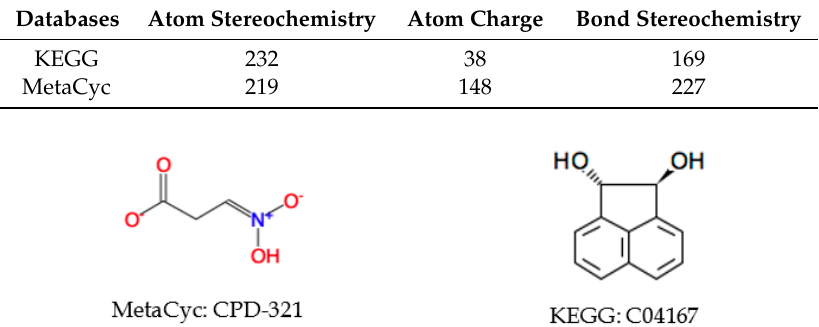
Table 9. Compounds gaining asymmetry after addition of extra information in the atom naming.